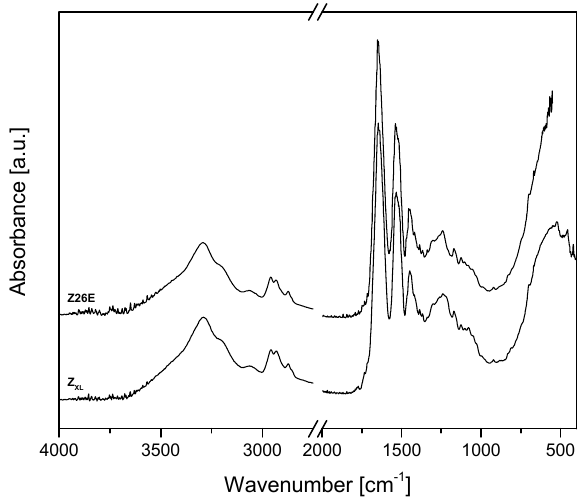
Figure 9. FTIR spectra of Z26E and cross-linked zein.